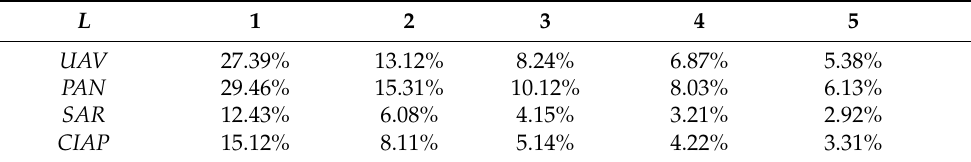
Table 1. Average median percentage for different L values for hypothetical sets of four datasets.